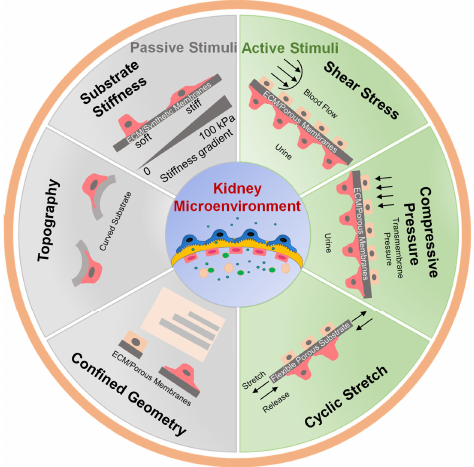
Figure 1. Kidney cell microenvironment and the mechanical stimuli applied to cells to mimic the physiological environment.